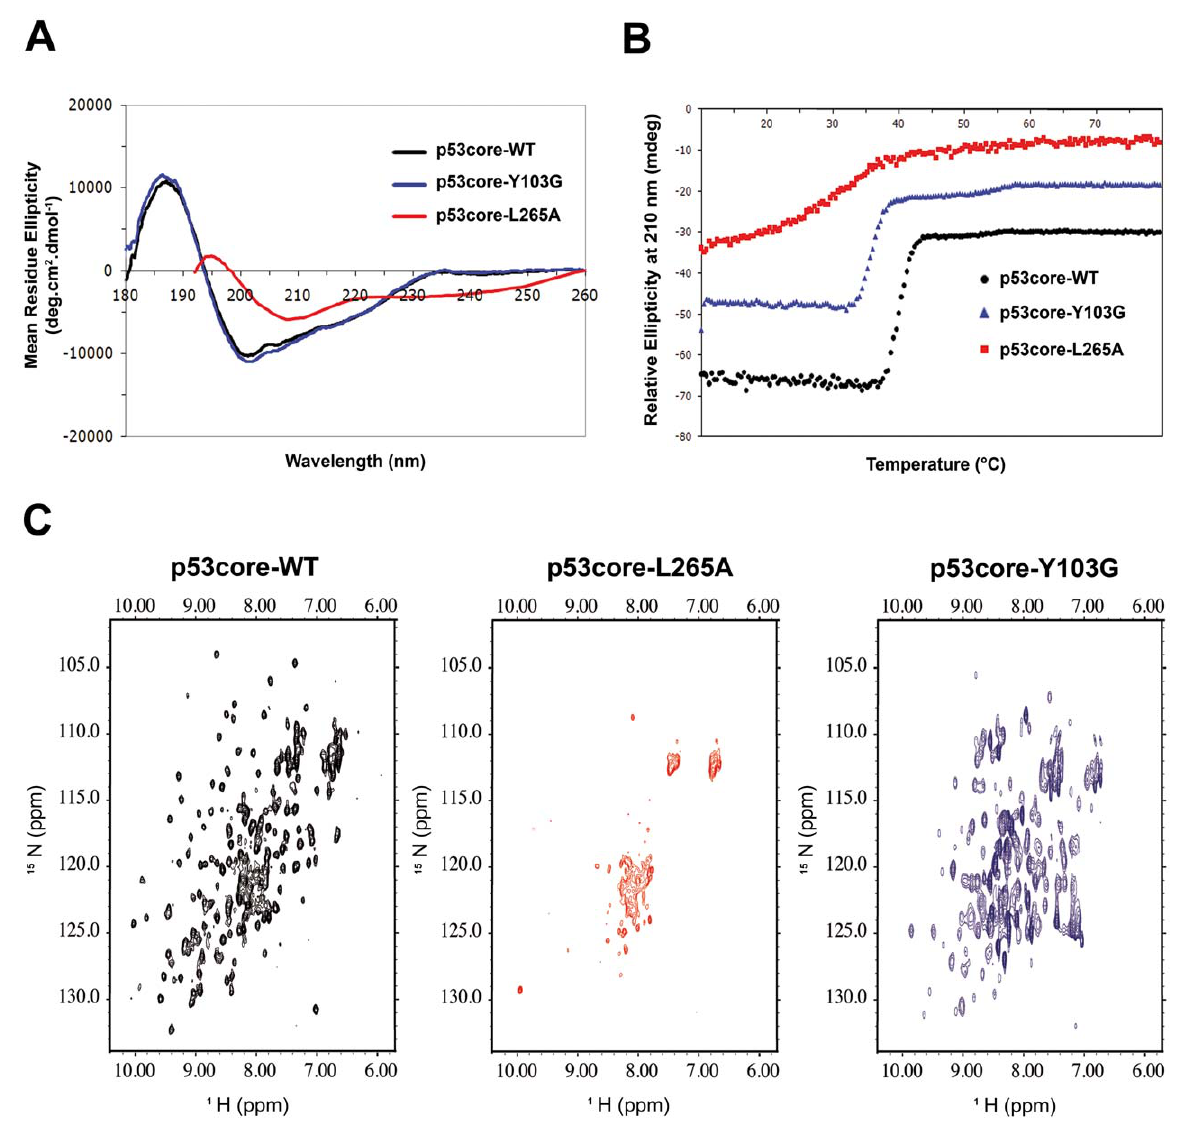
Figure 7. Biophysical analysis of Wt and mutant p53 core domain. (A) Comparison of different p53 core domain proteins (WT, L265A, Y103G) with respect to secondary structure content by CD. The spectra were recorded in 20 mM sodium phosphate (pH 6.8), 20 mM NaCl, 2 mM DTT at 10 u C. The far-UV spectrum of the p53wt and p53Y103G are similar and show characteristics of folded proteins with a minimum at 201 nm while the spectrum of the L265A p53 core domain suggests a large proportion of unfolded protein as indicated by the shift of the minimum towards smaller wavelength and a negative signal at 200 nm. (B) Thermal denaturation of the p53 core domain proteins monitored by far-UV CD spectroscopy at 210 nm. The spectra were recorded in 20 mM sodium phosphate (pH 6.8), 50 mM NaCl, 2 mM DTT. For clarity, spectra have been offset by 10 mdeg between each curve. (C) 1 H- 15 N correlation spectra of p53 core domain (residues 94–312) acquired at 10 u C on a Bruker DRX600 spectrometer equipped with a z-gradient triple resonance cryoprobe. The p53WT core domain is represented in black (left panel), the p53L265A core domain in red (middle panel) and the p53Y103G core domain in blue (right panel).